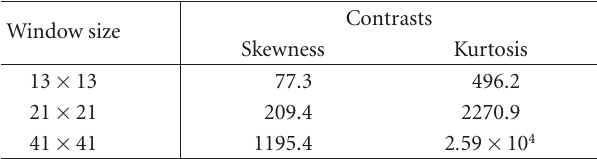
Table 2: Detection performances of the HOS (contrast), with an SNR of 50dB, in function of the size of the computation